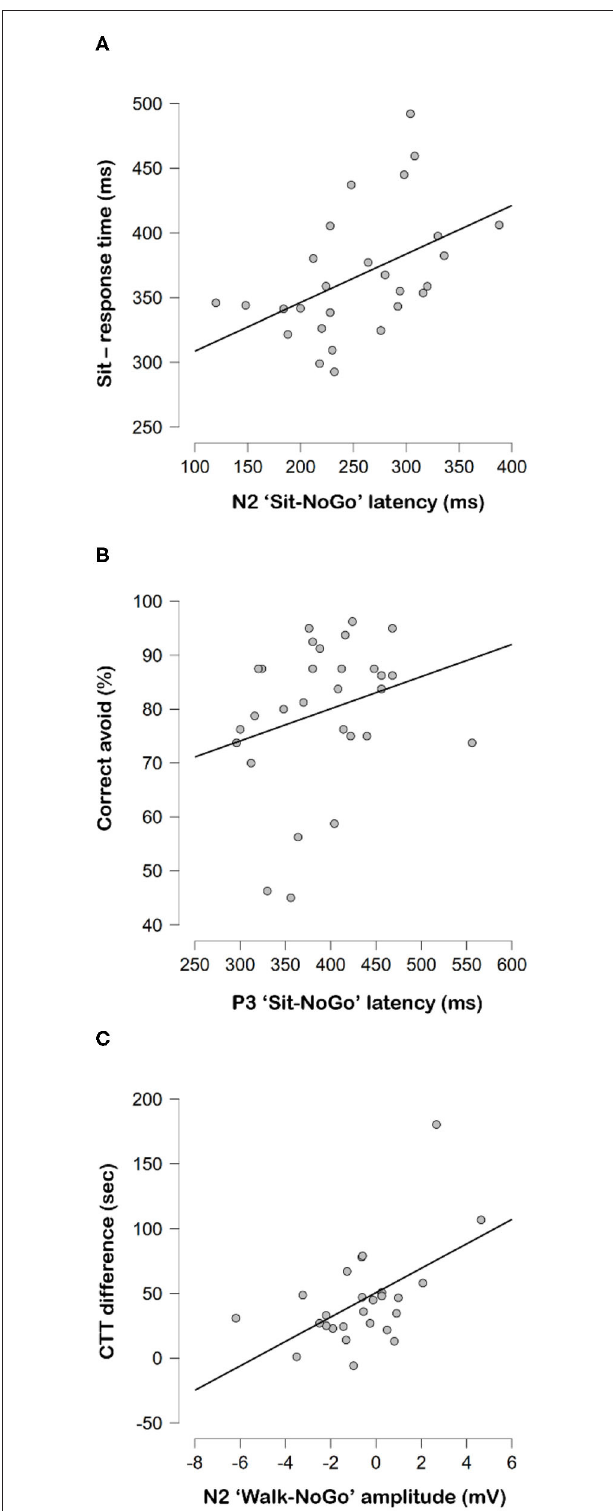
FIGURE 5 | Correlations between (A) N2 “Sit-NoGo” latencies to response time while sitting, (B) P3 “Sit-NoGo” latencies to correct avoid rates (%) and (C) CTT difference and N2